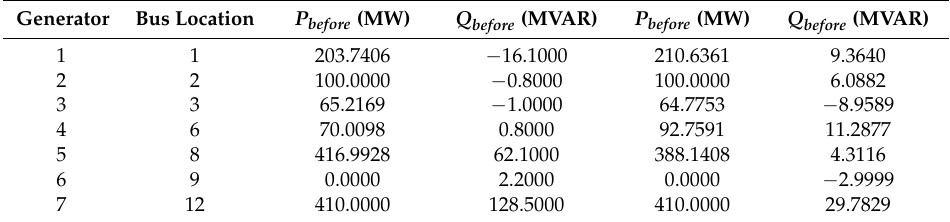
Table 1. The generator outputs before and after the remedial action in scenario 1.